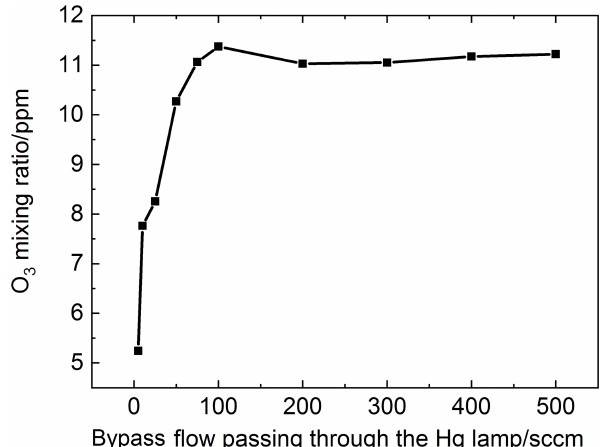
Figure 5. O 3 mixing ratio when the bypass flow passing through the Hg lamp